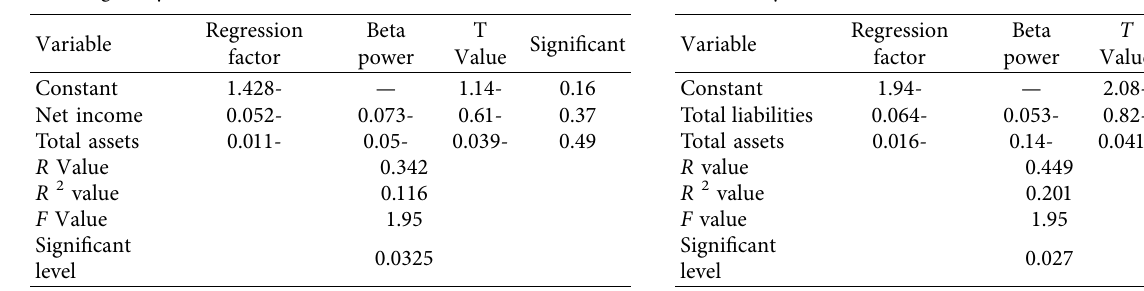
Table 10: Results of multiple linear regression analysis of the efect of listing analysis on return on assets.